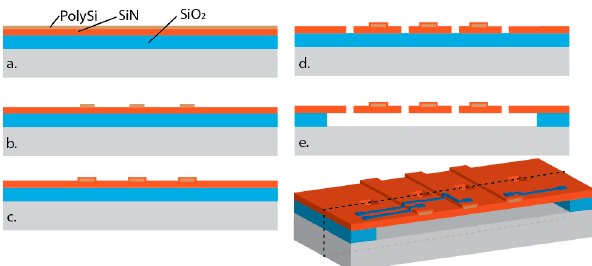
Figure 5. Fabrication process: ( a ) deposition of the SiO 2 , SiN, and polysilicon layers; ( b ) patterning, etching, and doping of the polysilicon layer; ( c ) passivation and deposition and patterning of the interconnects; ( d ) patterning of the sacrificial access holes; ( e ) sacrificial etching of the SiO 2